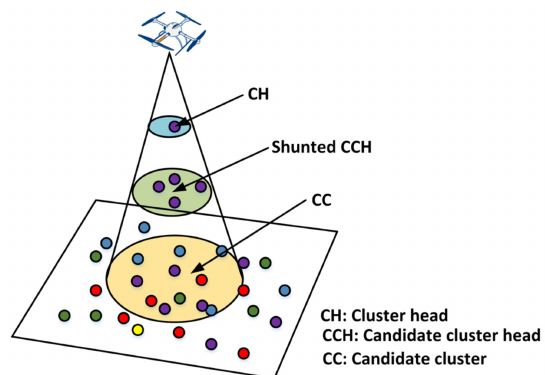
Figure 3. Data collection method in UAV-assisted routing protocol (URP).